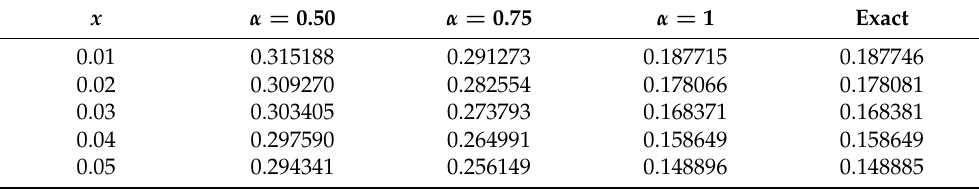
Figure 2. The different surfaces of approximate solutions and the exact solution. ( a ) Approximate solution plot of Equation (14) for different values of α . ( b ) Approximate solution of Equation (14) and exact solution of Equation (15) at α = 1. ( c ) The surface solution of Equation (14) at α = 0.50. ( d ) The surface solution of Equation (14) at α = 0.75. ( e ) The surface solution of Equation (14) at α = 1. ( f ) The surface solution of Equation (15) at α = 1. Table 1. Comparison between approximate solutions of Equations (14) and (15) when t = 0.2. x α =